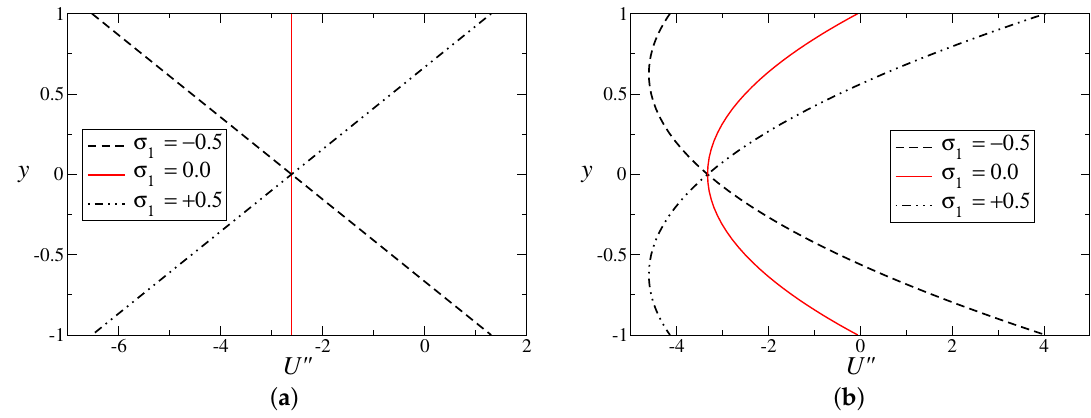
Figure 3. Second derivative of mean velocity profiles ( U ( y ) ), for different values of σ 1 : ( a ) σ 2 = 0.0; ( b ) σ 2 = 0.2. In both the figures, symmetric slip ( β 1 = β 2 = 0.05) is